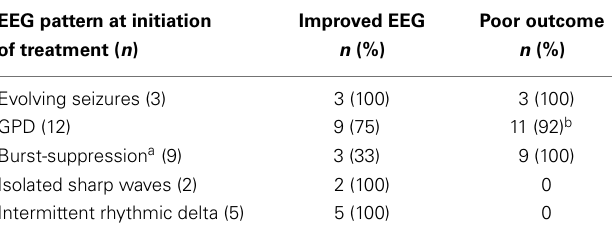
Table 2 | Proportions of patients with improved EEG or poor outcome after treatment with (combinations of) anti-epileptic drugs, according to the EEG pattern at the initiation of treatment.